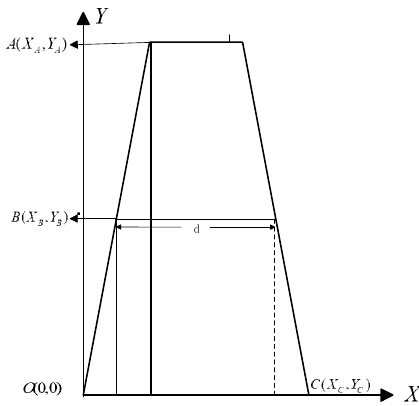
Figure 3. Geometric model of laser profilometer from single measurement.